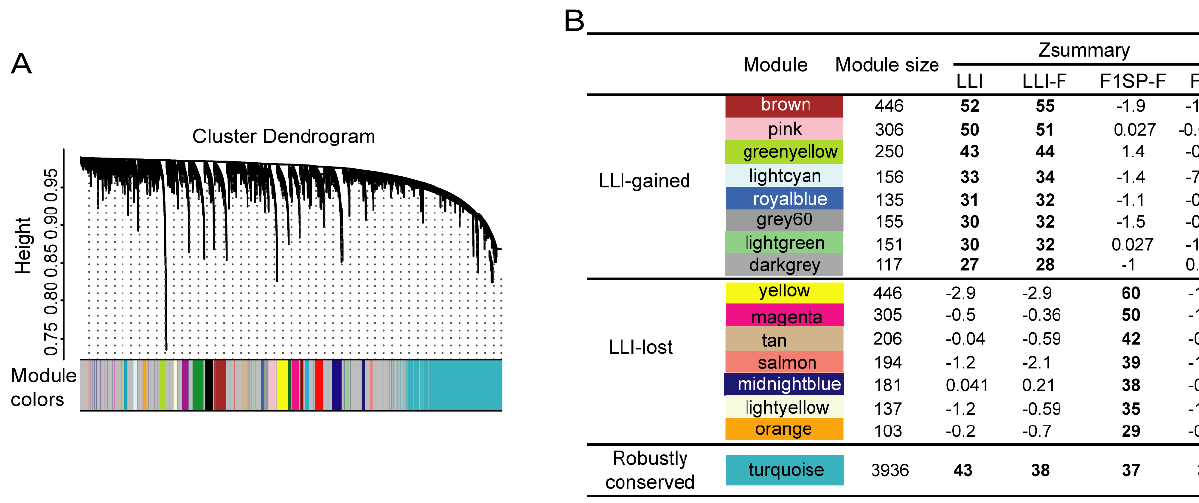
Figure 2. Construction of weighted circRNA co-expression network. ( A ) Module tree plot of circRNA- circRNA in all samples generated by blockwiseModules and plotDendroAndColors parameters in WGCNA package. Each color represents one co-expression module. ( B ) Module preservation analysis results. Each color represents one co-expression module. Preservation degree of modules was assessed by Zsummary scores (value > 10 was regarded as strong preservation). One module with higher Zsummary score indicates its stronger conservation in the sample group